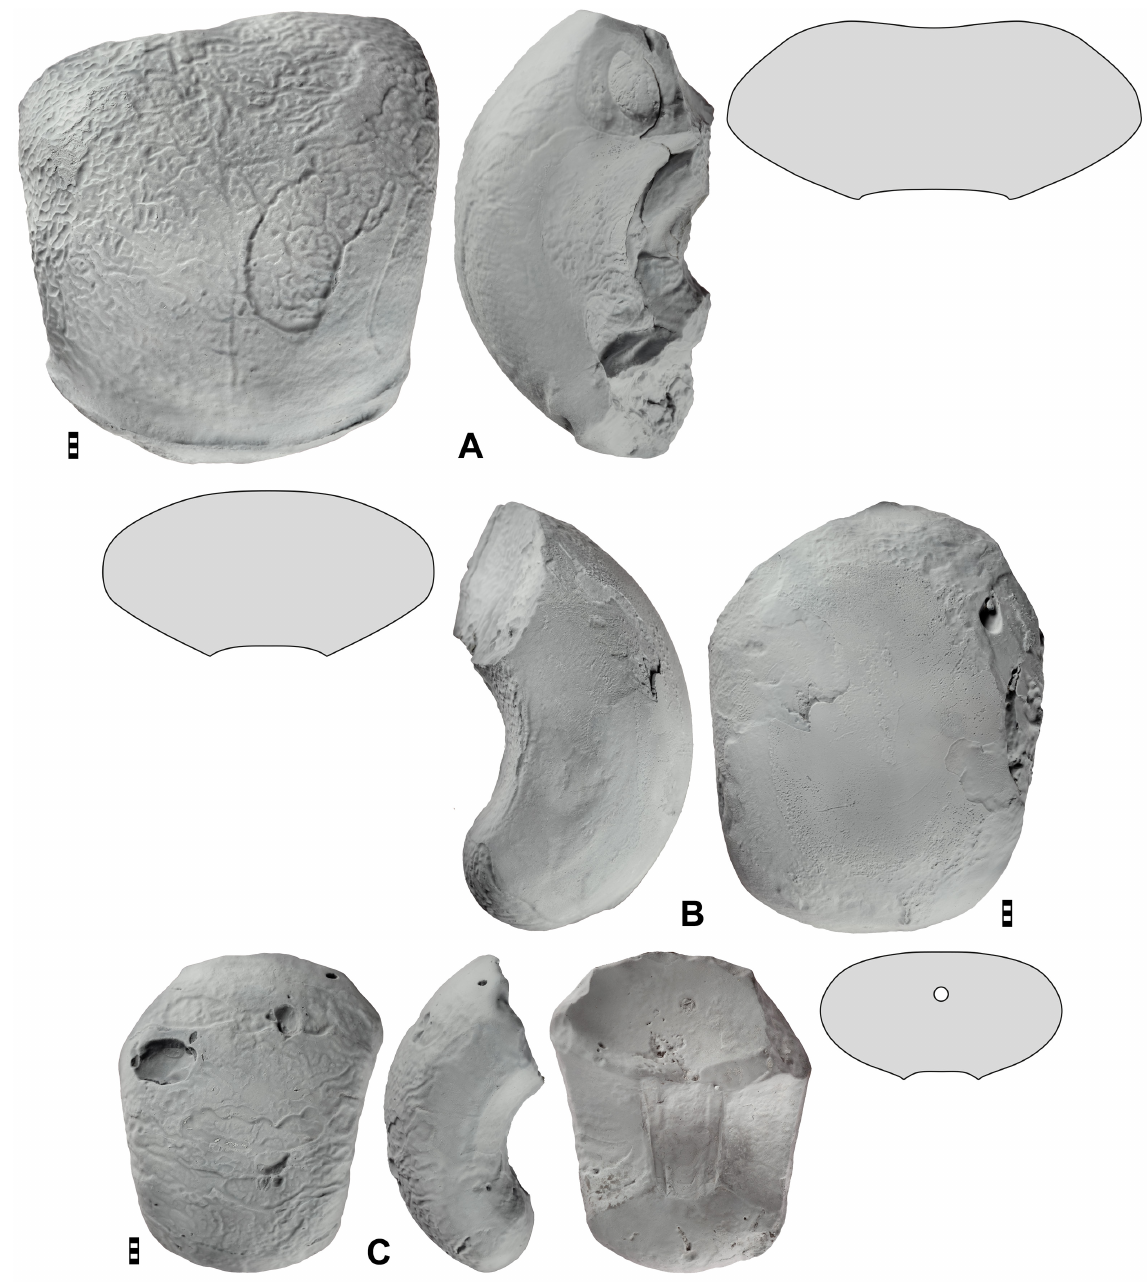
Fig. 21. Vestinautilus bicristatus sp. nov. from Oued Temertasset (all Korn et al . 2002 Coll.). A . Paratype MB.C.30474.1. B . Paratype MB.C.30474.2. C . Paratype MB.C.30474.3. Scale bar units = 1